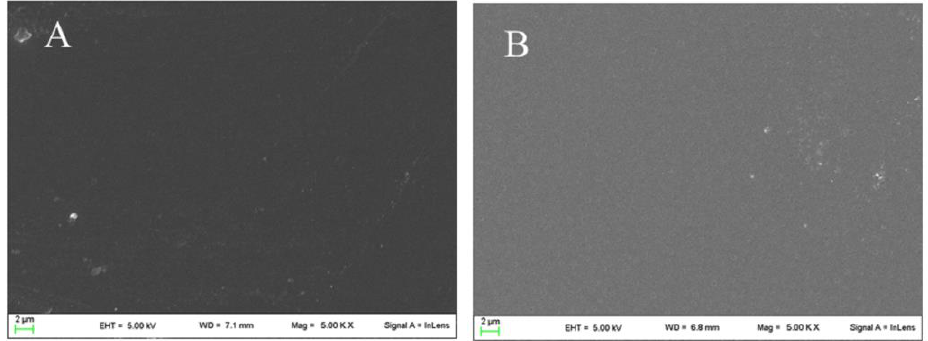
Figure 3. SEM micrographs of Chitosan ( A ) and CBPR 2% ( B ).